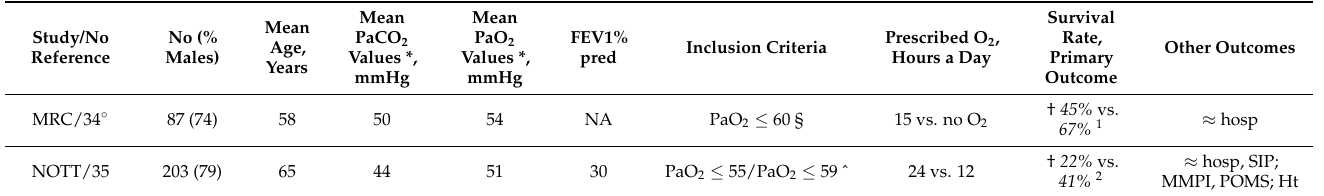
Table A3. Some characteristics of main studies evaluating the significance of LTOT in COPD subjects with chronic severe respiratory hypoxemia.